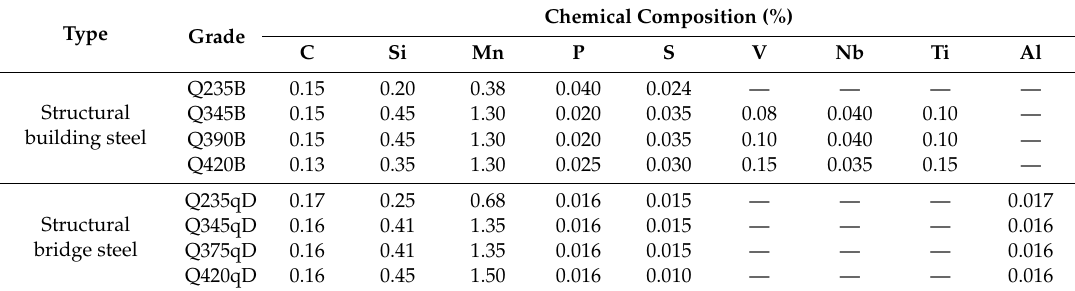
Table 1. Quality composition and mechanical properties of structural steel